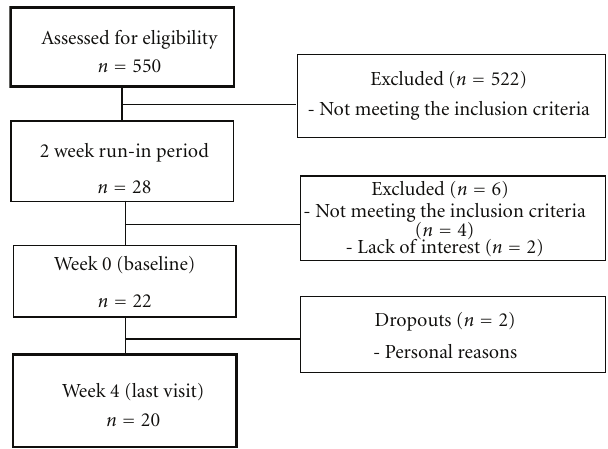
Figure 1: Flow diagram of the study.